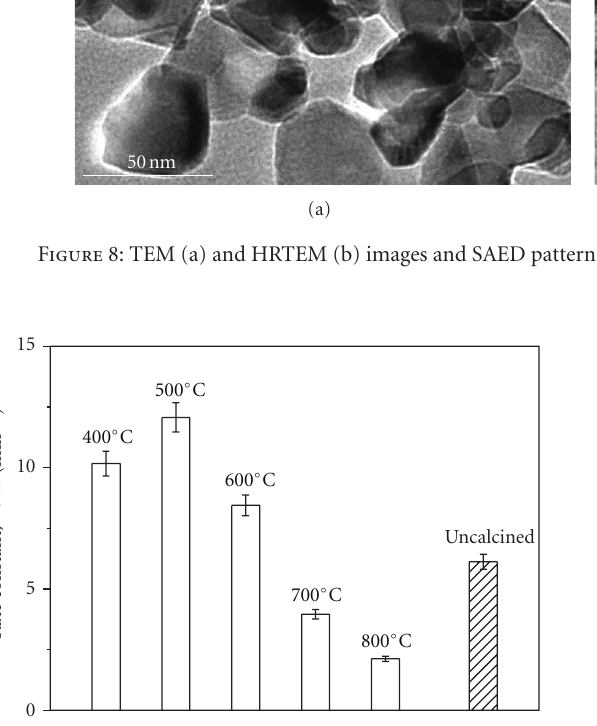
Figure 9: E ff ects of calcination temperatures on the apparent rate constants of the P25